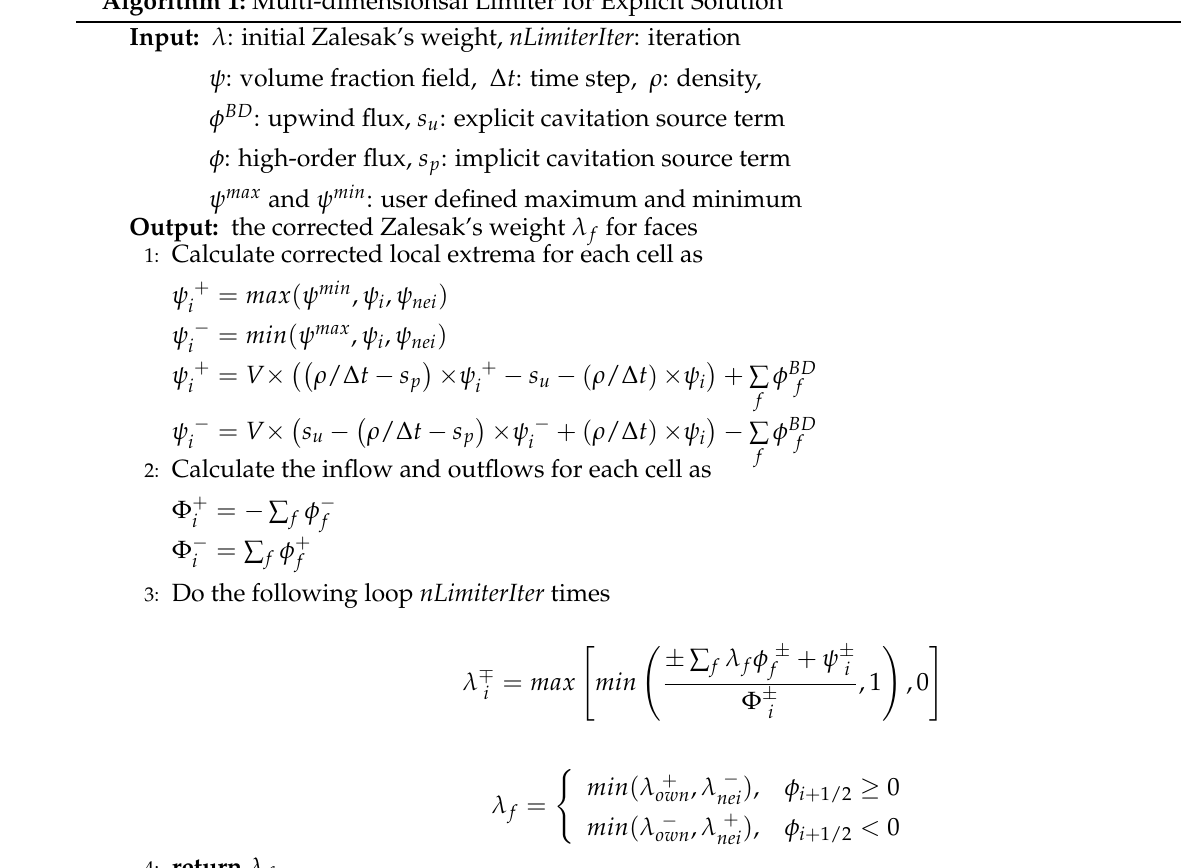
Algorithm 1: Multi-dimensionsal Limiter for Explicit